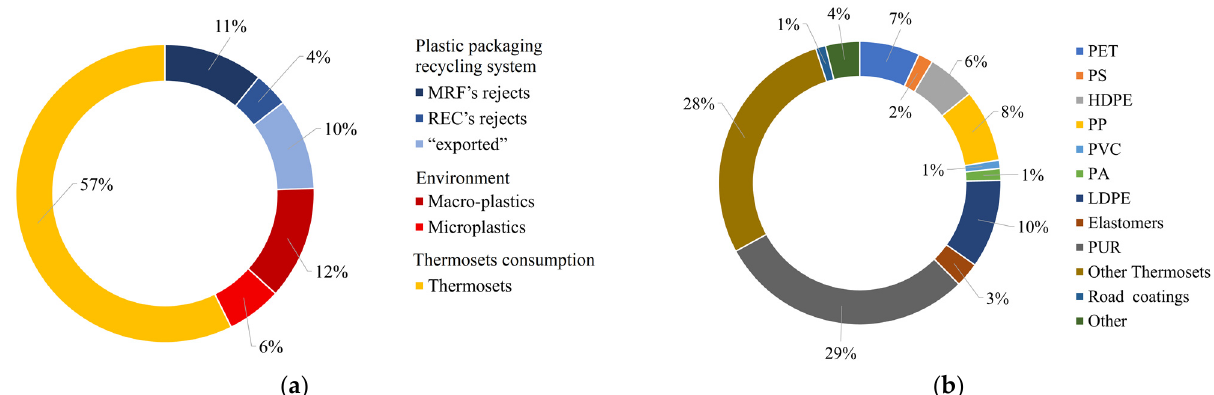
Figure 6. Unrecycled PCPW flows potentially included in future recyclable flows in the EU (Total 18,514 kt y − 1 ): ( a ) divided by source; ( b ) divided by polymer composition. Elaborated from data collection and research conducted for this review article.